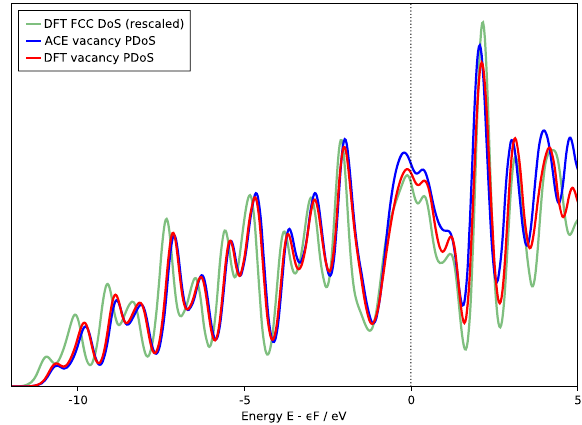
Fig. 9 Comparison of PDoS for a 728-atom Al vacancy supercell between the reference DFT results (red) and those predicted by our ACE Hamiltonian model (blue), which was not trained on vacancy data. PDoS includes orbitals associated with the nearest neighbours of the vacancy. The PDoS for the perfect FCC structure is shown in green to allow the changes in the electronic structure due to the defect to be